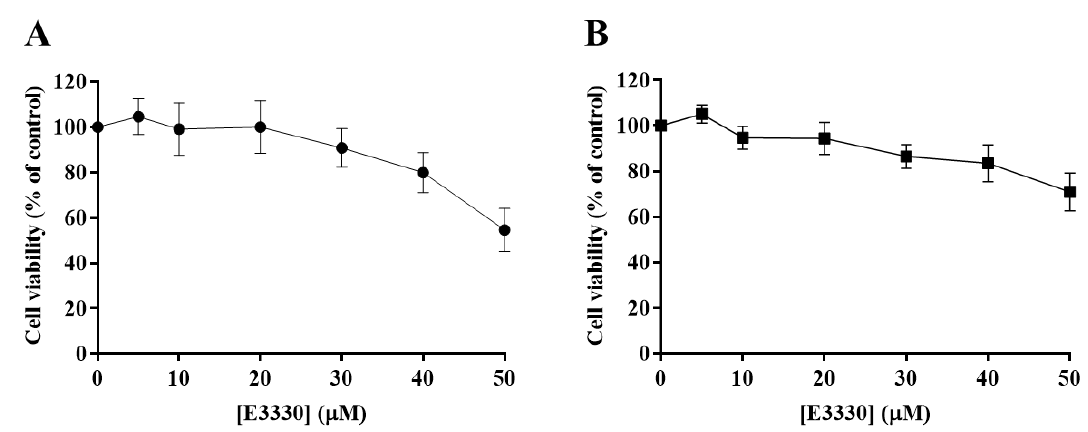
Figure 3. Evaluation of E3330 (5–50 µ M) cytotoxicity in H1975 cells. The cell viability of E3330-exposed cells (72 h) was evaluated by CV staining ( A ) and MTS reduction ( B ) assays. Values represent mean ± SD ( n = 3) and are expressed as percentages of the vehicle-treated control cells.